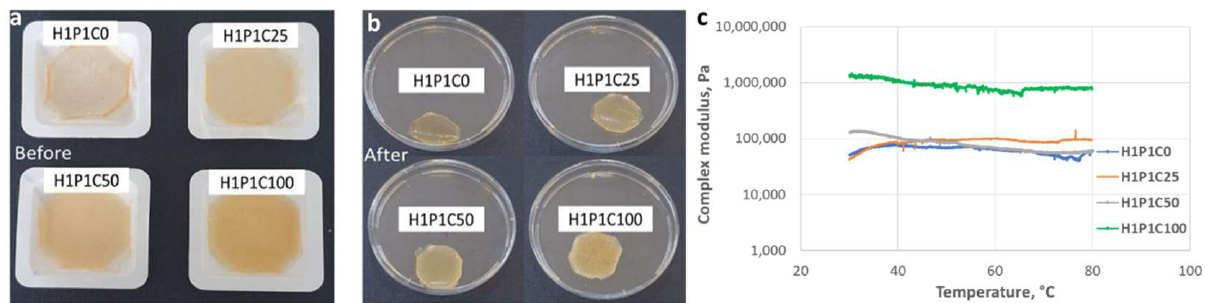
Figure 3. Samples ( a ) before and ( b ) after purification. ( c ) Rheological behaviour of H1P1C25/50/100 hybrids versus H1P1C0.